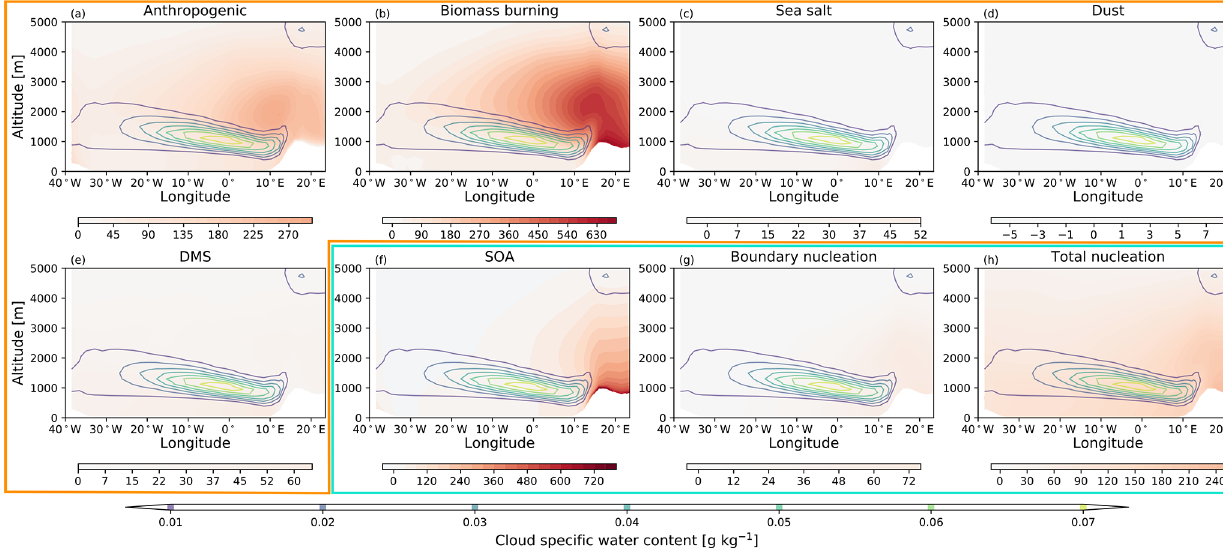
Figure 4. UKESM1-simulated annual mean vertical profiles of the CCN concentration at 0.2% supersaturation (CCN 0 . 2% ) from different sources (at standard temperature and pressure, STP). Profiles are averaged along the latitudes of the cloud box. The contributions of different sources to CCN 0 . 2% are listed in subplots (a) to (h) , where the contribution of emissions is shown using the orange frame, and the contribution of atmospheric processes is shown using the teal frame. Note that boundary layer aerosol nucleation is based on organic-mediated aerosol nucleation and is limited to the boundary layer. Total aerosol nucleation includes boundary layer nucleation and homogeneous binary aerosol nucleation in the free troposphere and stratosphere. The contour lines in each subplot are the cloud specific water content from the baseline simulation at the same temporal and spatial average. The same colour map scale is used in each subplot to facilitate comparison, but the range differs for each plot, corresponding to the maximum and minimum CCN 0 . 2%